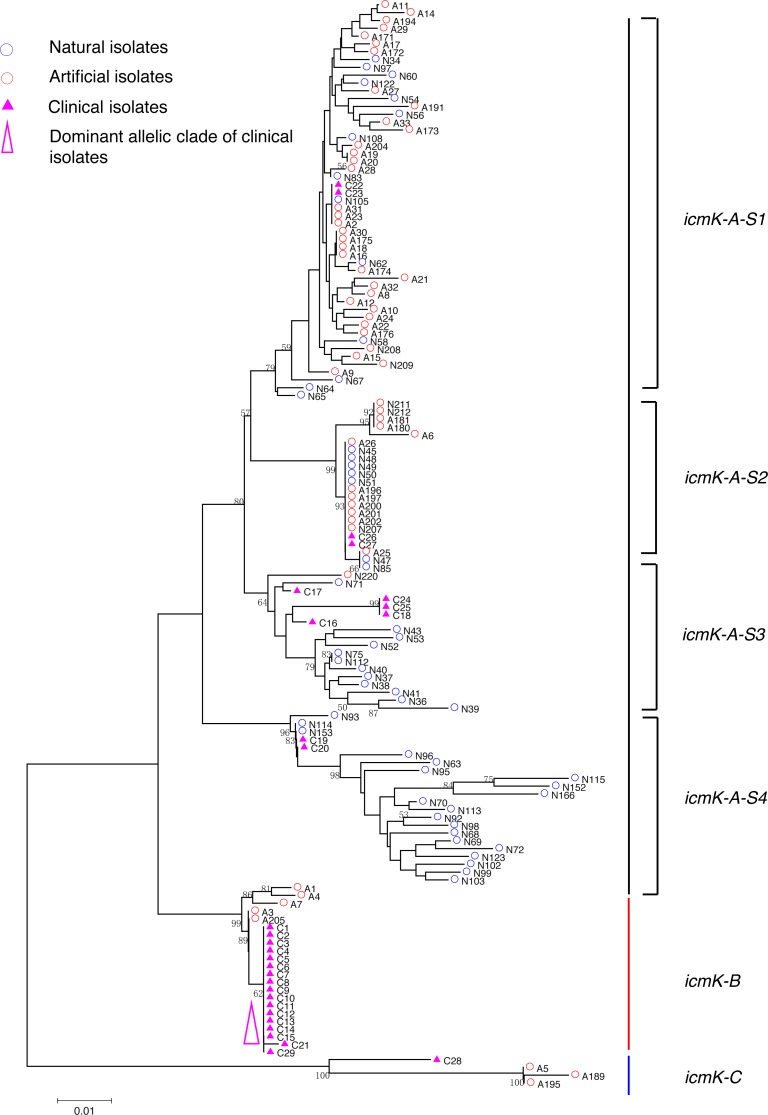
Neighbor-Joining tree of L. pneumophila isolates from DNA sequences of icmK locus.Strain types, source natures and geographic locations of these isolates were shown in Table S1. Bootstrap support values (1,000 replicates) for nodes higher than 50% are indicated next to the corresponding node. Three main groups of the clades could be found.